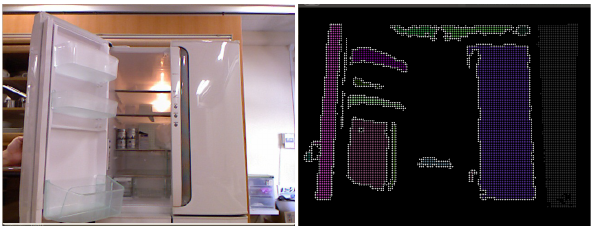
Figure 2: Surface extraction by means of region